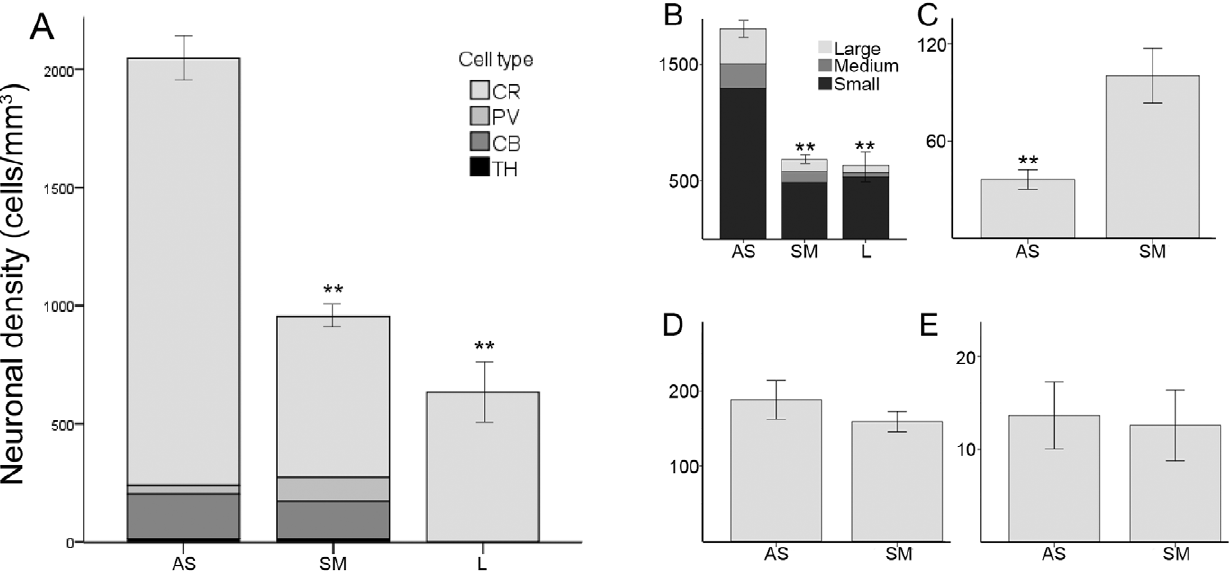
Figure 3. Neuronal density of the various groups of neurons in the functional territories of the striatum. A, stack bar graph showing the global interneuronal density. The colors of the stacks indicate different chemospecific subsets of neurons. B, stack bar showing the density (cells/ mm 3 ) of large, medium and small CR-ir interneurons. C–E, neuronal density (cells/mm 3 ) of the PV-, CB- and TH-ir neurons, respectively. Error bars indicate the SEM. **, P , 0.01. AS, associative; L, limbic; SM,